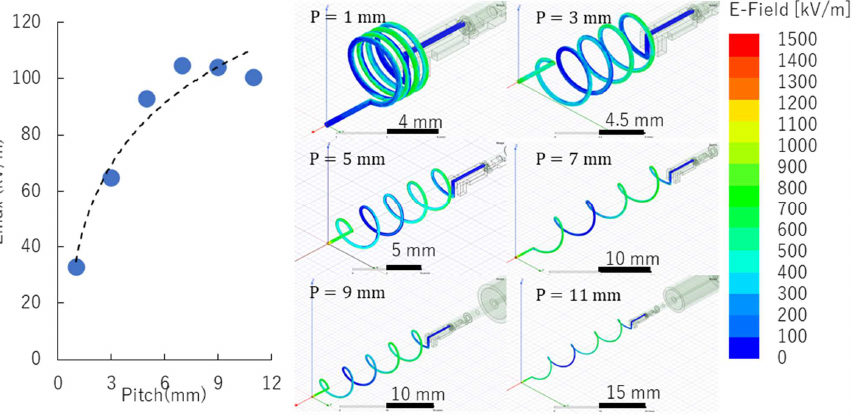
Figure 5. Electrical field strength and coil pitch optimization.